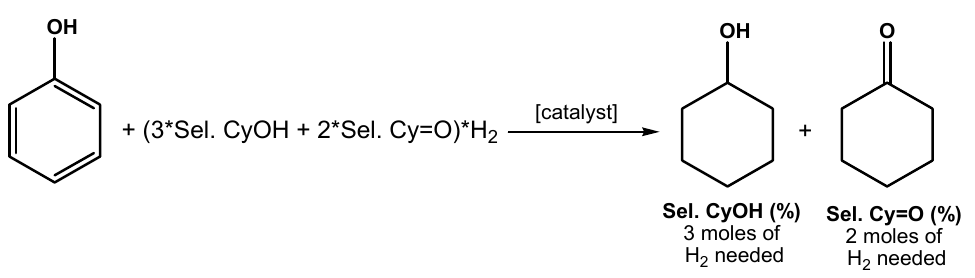
Scheme 4. Typical illustration for calculation of hydrogen consumed.